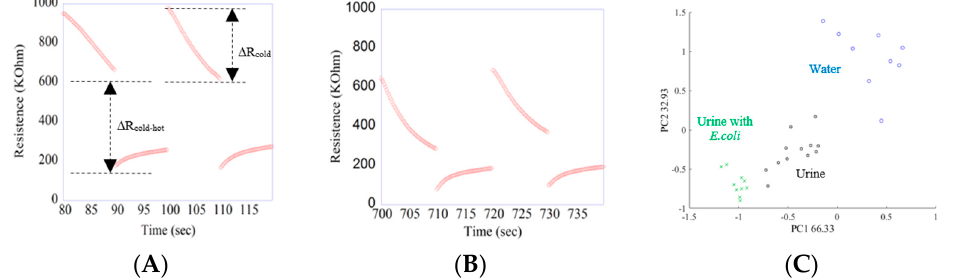
Figure 1. Resistance vs. time curves obtained with the CSS801 sensor. Two cycles of a cold and warm semi-period recorded during the exposition to the VOCs released by urine’s samples ( A ). Two cycles of a cold and warm semi-period recorded during the exposition to the VOCs released by urine contaminated with E. coli samples ( B ). A Principal Component Plot of the MOX sensors response to the VOCs released by water (blue circles), urine (black stars) and urine with E.coli (green crosses) ( C